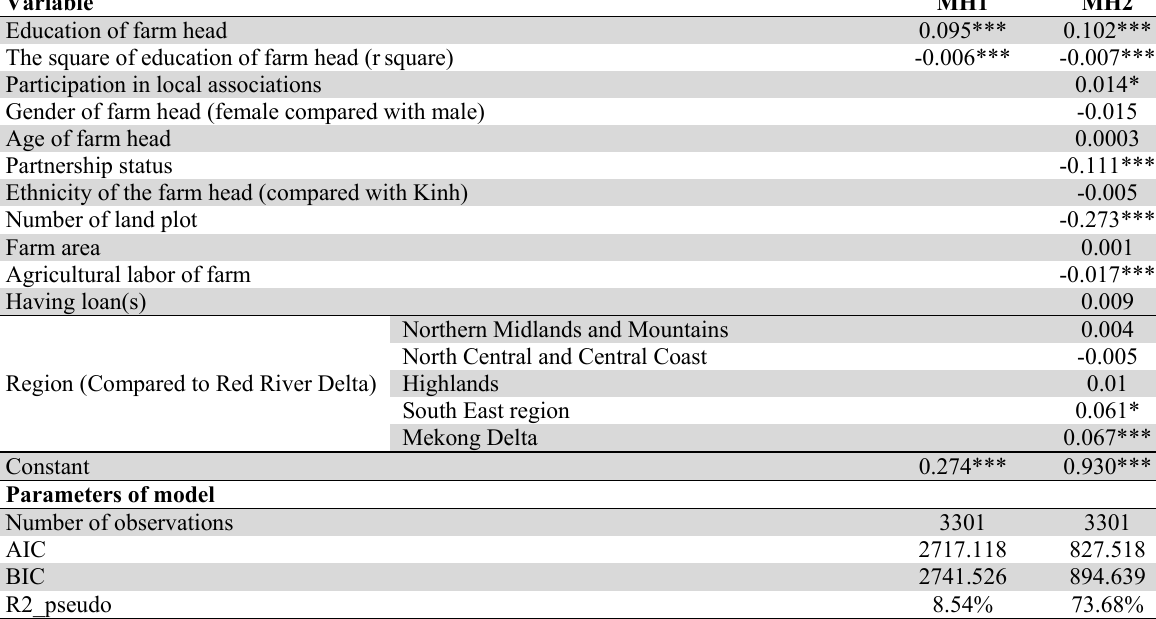
Estimated results for determinations of technical